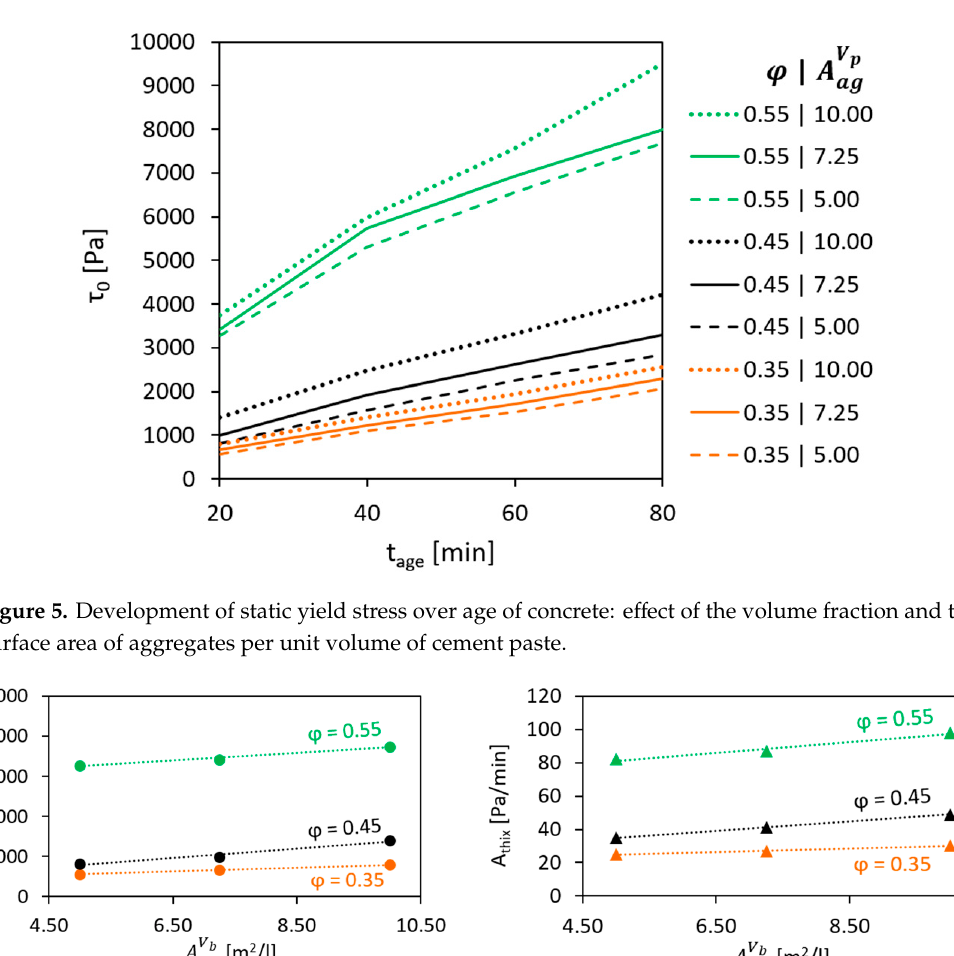
Figure 6. Effect of the surface area of aggregates per unit volume of cement paste on ( a ) the initial SYS and ( b ) the structural build-up rate of concrete.